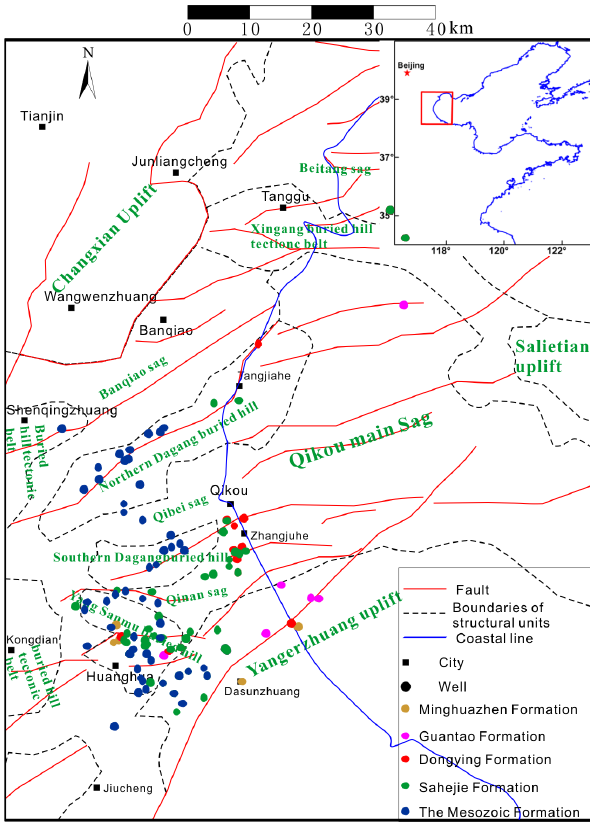
Fig. 6. Simplified geological map of the Qikou depression, eastern China. The red square in the upper right corner of the map indicates the regional location of our study area. Coloured circles represent the locations of wells that drilled through different volcanic rocks (modified from Yang et al., 2010).